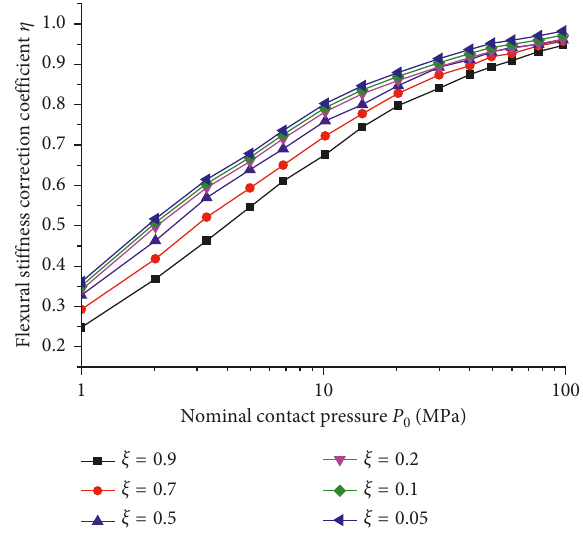
Figure 8: Effect of the pretightening force and the bending moment on η .